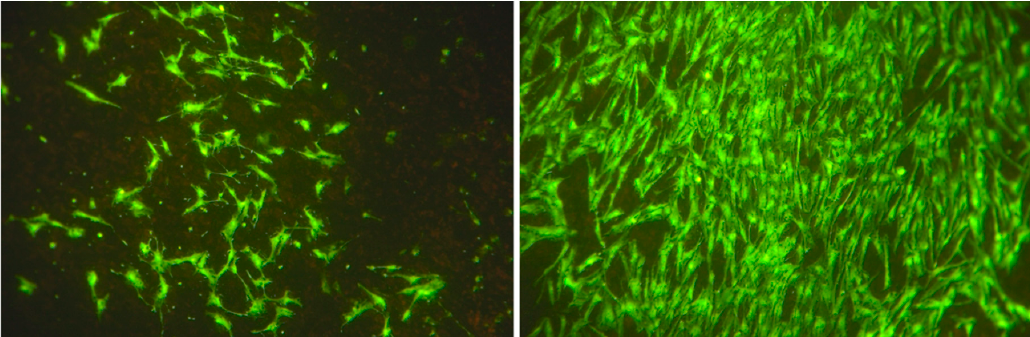
Figure 6. Evaluation of cell number and cellular surface coverage of adipose-derived stem cells electrically stimulated (4A) and non-stimulated (4B) at day 7 (original magnification ×100).